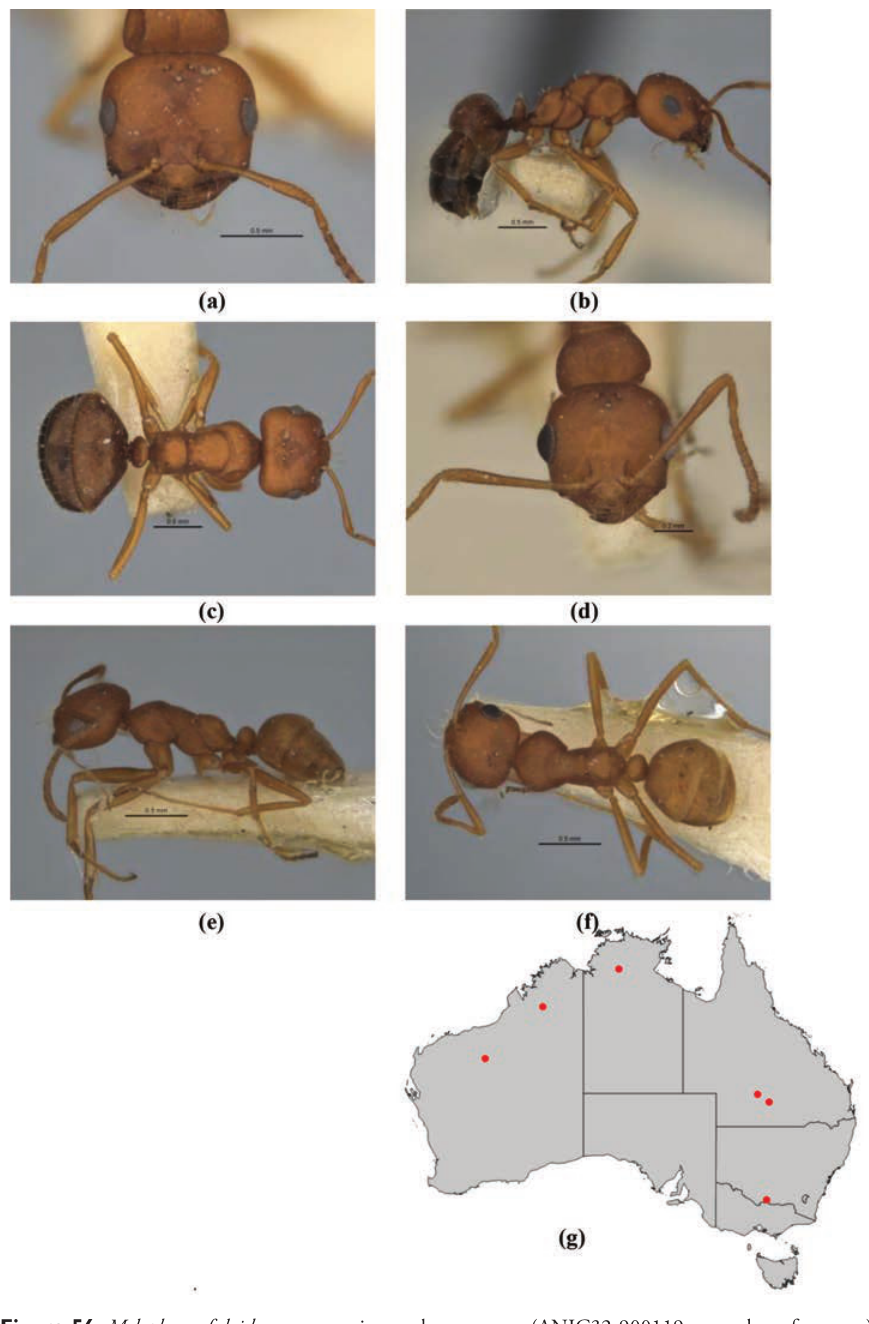
Figure 56. Melophorus fulvidus sp. n.: major worker paratype (ANIC32-900119–second ant from top) frons ( a ), profile ( b ) and dorsum ( c ); minor worker holotype (ANIC32-900119–top ant) frons ( d ), pro- file ( e ) and dorsum ( f ); distribution map for the species ( g ). Low resolution scale bars: 0.5 mm ( a–c, e, f ); 0.2 mm ( d